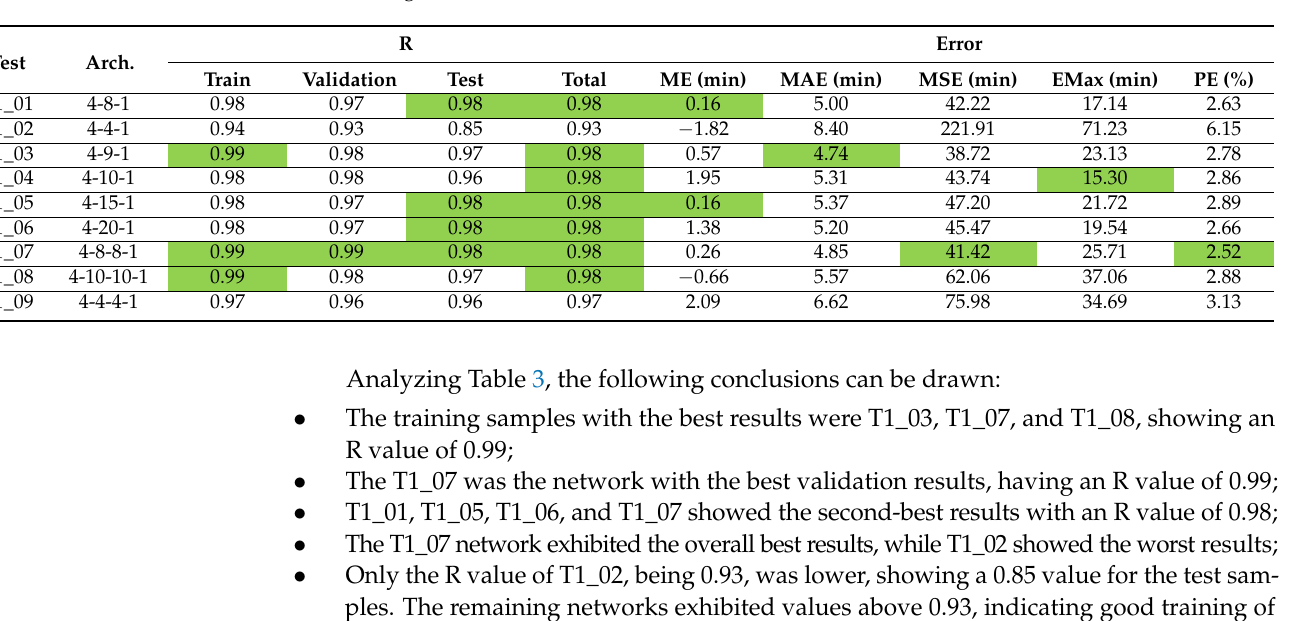
Table 3. Regression and error of the ANNs from Test